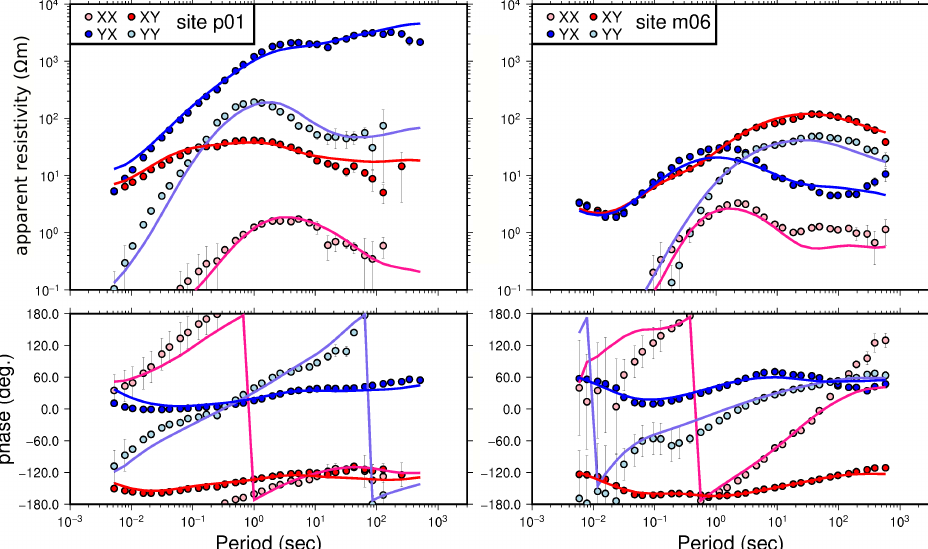
Figure 2. MT impedance tensor for sites p01 and m06 (northern and southern profiles respectively, see Figure 1B for location). The four complex tensor components are Z xx (pink), Z yy (cyan), Z xy (red) and Z yx (blue) shown as apparent resistivity and phase (dots). The error bars are one standard deviation. Full lines correspond to the response of the best 3-D model. See text for